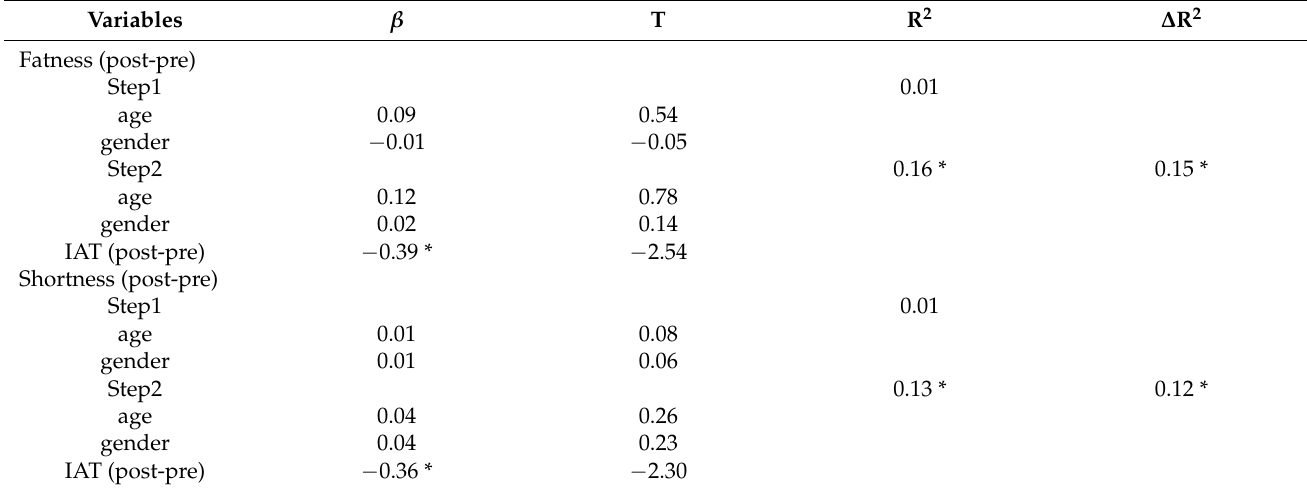
Table 5. Predictive role of IAT